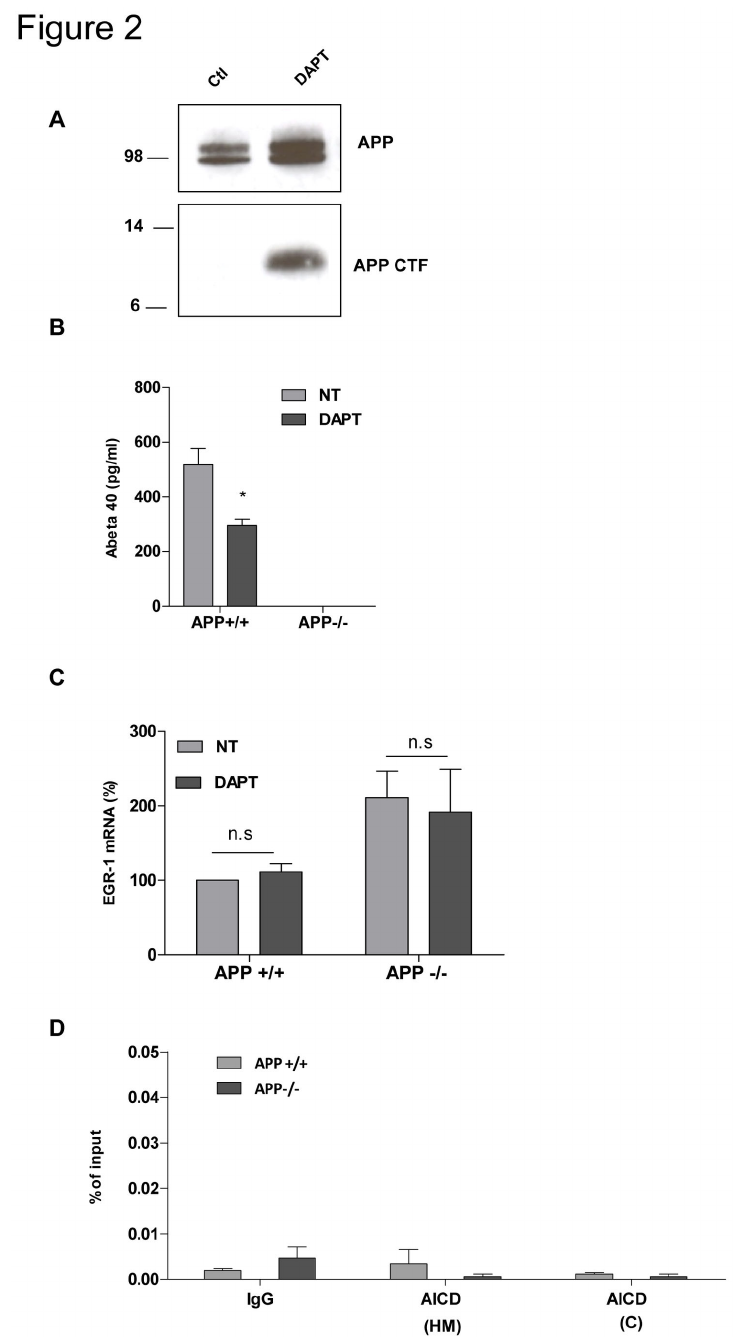
Figure 2. Pharmacological inhibition of γ-secretase does not affect APP-mediated control of EGR-1 expression. A) Western blot analysis of cellular extracts from control neurons (Ctl) or neurons treated for 8h with 250nM DAPT (DAPT). APP and APP CTF were detected by with an antibody raised against the C-terminal domain of APP. B) Aβ was quantified in the culture medium of APP+/+ or APP-/- neurons treated (DAPT) or not (NT) for 8h with 250nM DAPT. C) EGR-1 mRNA levels were quantified by q-RT PCR on APP +/+ and APP-/- neurons DIV5 treated (DAPT) or not (NT) for 8h with 250nM DAPT (n=3). Values were normalized to the GAPDH mRNA, and expressed as percentage of APP+/+. Results are expressed as mean ± SEM. D) Chromatin immunoprecipitation of EGR-1 promoter was performed on chromatin isolated from APP+/+ and APP-/- neurons DIV5 (n=3) using normal mouse IgG as negative control (IgG) and two different anti-C-terminal APP antibodies: anti-AICD homemade (HM) or commercial (C). Immunoprecipitated DNA was quantified by qPCR, and normalized to the input. doi: 10.1371/journal.pone.0074305.g002 PLOS ONE |